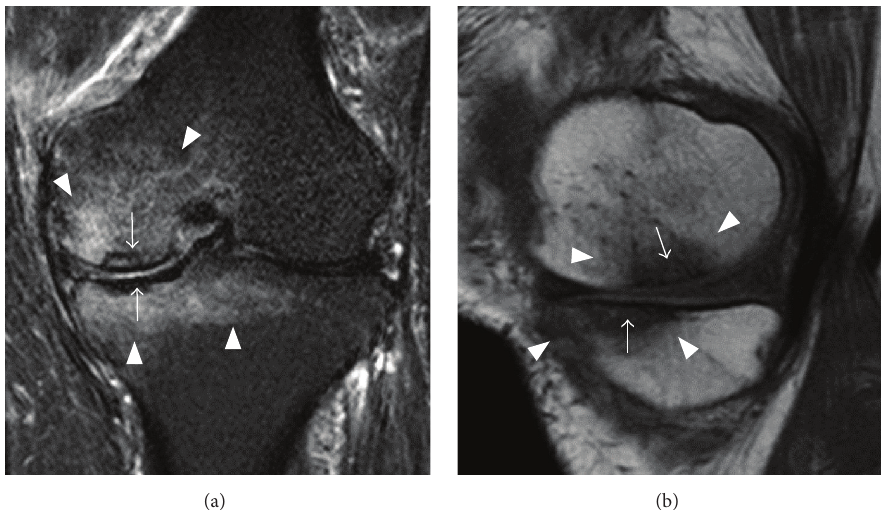
Figure 2: Initial MRI evaluation of our patient. (a) Coronal STIR and (b) sagittal T1 weighted images showing focal SPONK lesions at both the MFC and the MTP (arrow), surrounded by diffuse bone edema (arrowhead). MRI also showed a horizontal tear in the medial meniscus at the posterior horn.